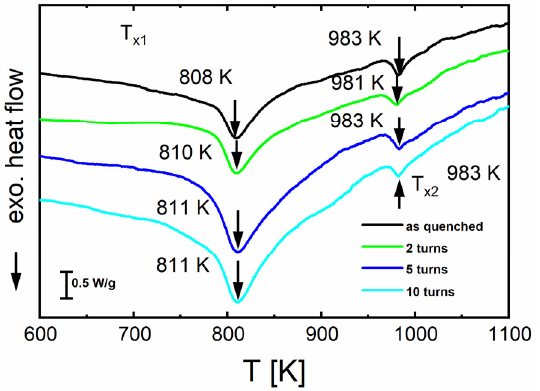
Figure 4. Constant-rate heating DSC scans (heating rate 20 K/min) of alloy A (Fe 73.9 Cu 1 Nb 3 Si 15.5 B 6.6 ) before (as-quenched) and after HPT deformation at N = 2, 5, and 10.